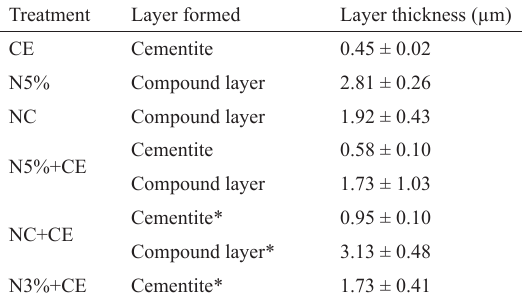
Table 4: Thickness of the layers obtained from the